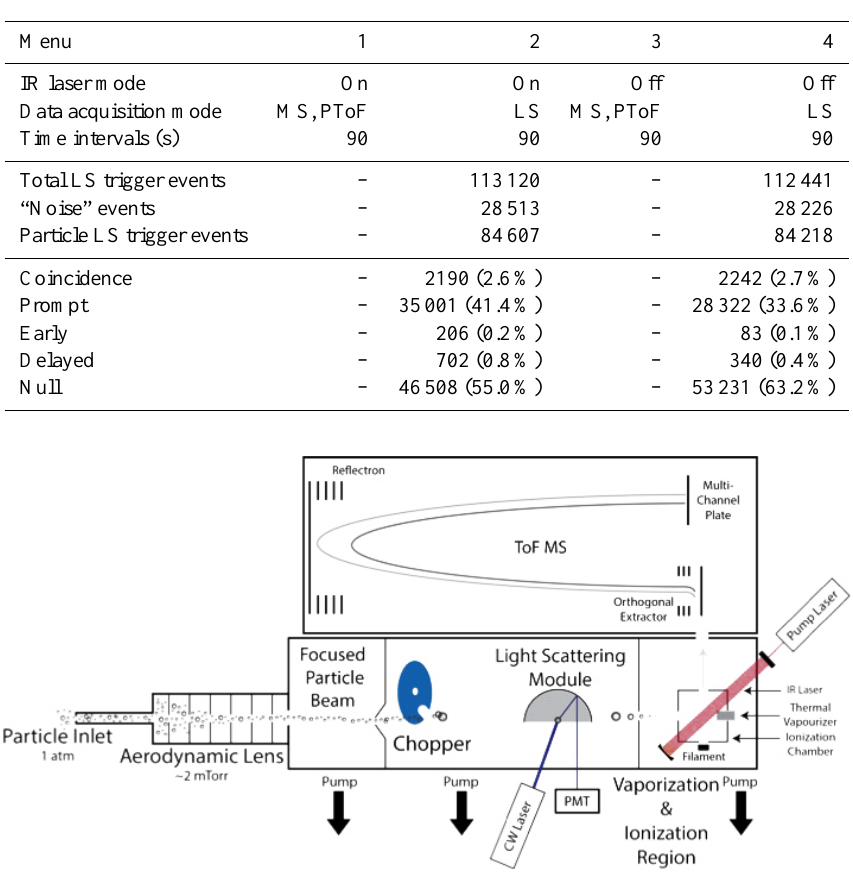
Table 1. Summary of menu switching in the LS-SP-AMS and single particle categorization.